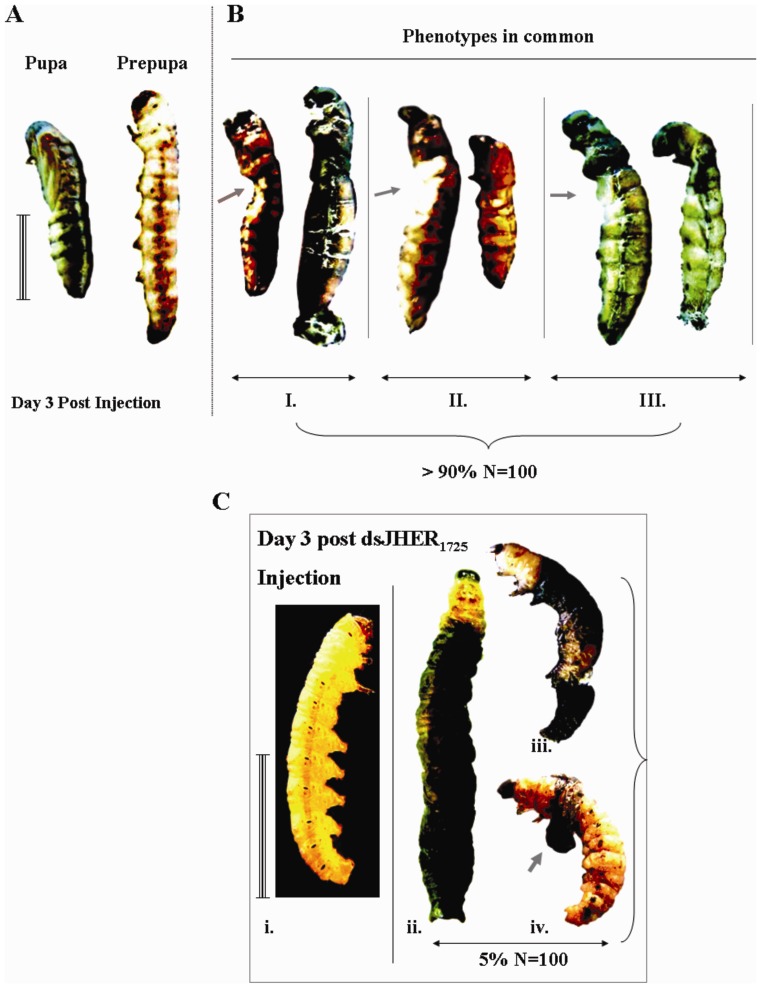
Phenotypic results after hemolymph administration of dsJHERs.
A. Left: Normal Pupa, Right: Normal 6th instar d9 larva (Prepupa). B. Targeting the SnJHER 472 bp (BI.) or the SnJHER 1276 bp (BII.) or the SnJHER 1725 bp (BIII.) part after hemolymph administration of dsJHERs in 6th instar d9 larvae. BI. Resulted larval-pupal intermediates after hemolymph administration of dsJHER472 in 6th instar d9 larvae, BII. Resulted larval-pupal intermediates after hemolymph administration of dsJHER1276 in 6th instar d9 larvae, BIII. Resulted larval-pupal intermediates after hemolymph administration of dsJHER1725 in 6th instar d9 larvae. The arrows indicate similar abnormalities observed in intermediates of all targeted regions. In each case, -I-, -II- or -III- the abnormalities were presented in an average of >90% of the injected animals, 3 days post injection, (N = 100). C. Developmental abnormalities of dsJHER1725 5th instar d3 injected larvae. i. Normal larva, ii. Abnormal larva with fused (double) melanized epidermis of the previous instar. iii. Lateral view of abnormal larvae with fused epidermis. iv. The same larva of previous case -iii.-, by removing the melanized epidermis. The arrow indicates the fusion point between the previous and the new epidermal tissues. The newest epidermis is of yellowish colour. Scale bar: 1 cm